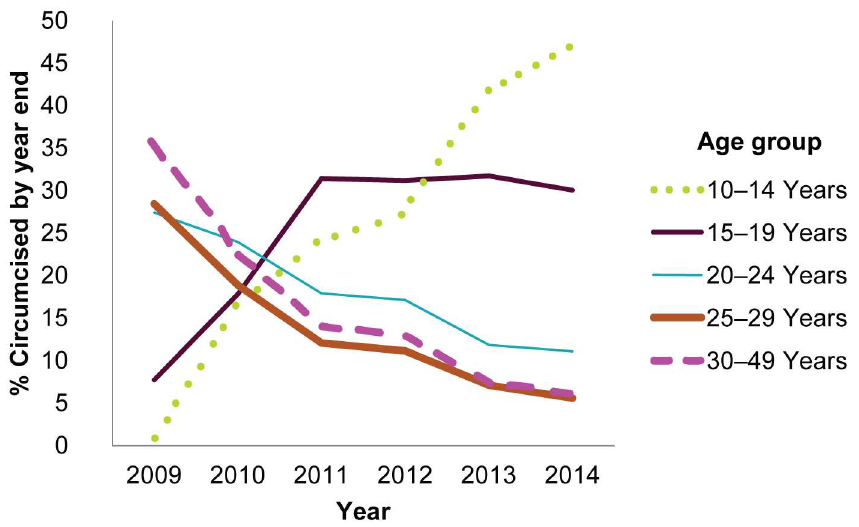
Fig 4. Trends in the proportion of each age group among VMMC clients over